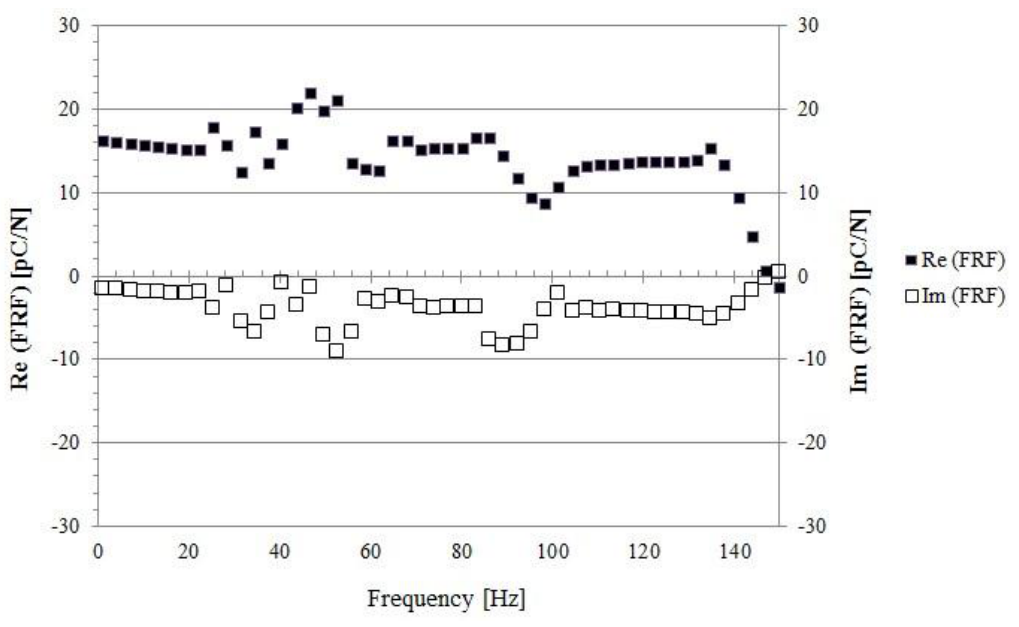
Figure 14. The system response function FRF (Re and Im) over the range 1–150 Hz is shown.